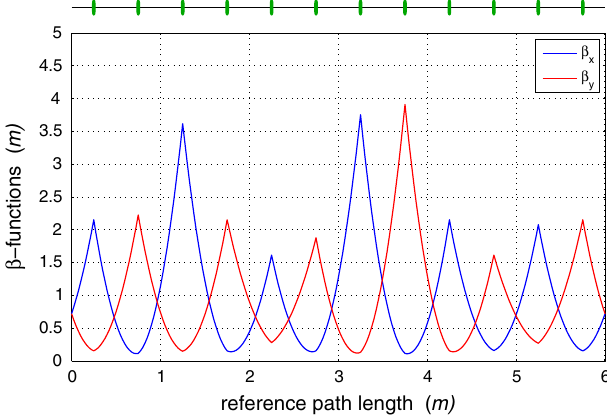
FIG. 5. Betatron functions along the phase advance scan beam ¼ (cid:8) ¼ (cid:4) 40 (cid:8) . line for (cid:8) x y